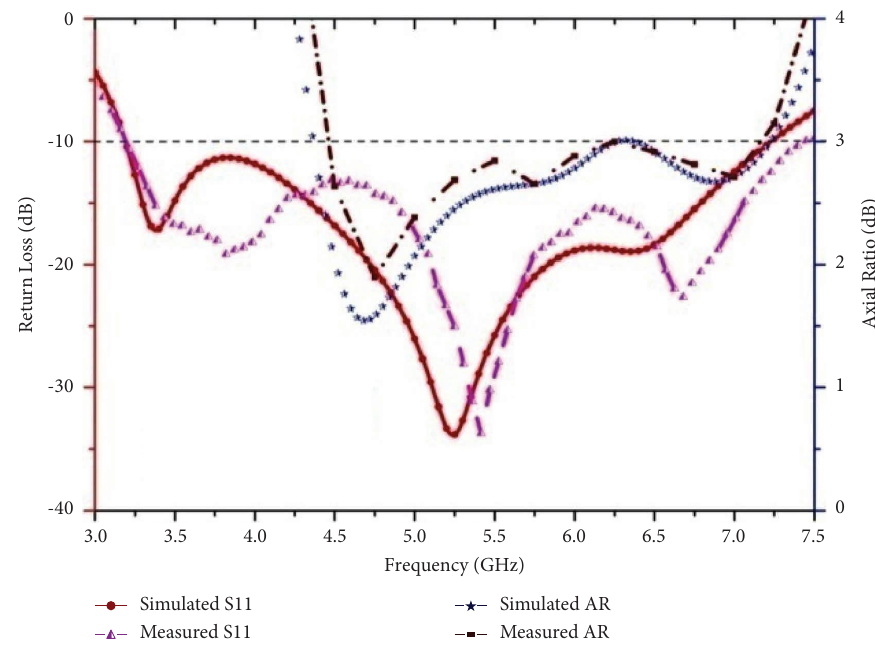
Figure 10: Simulated and measured plots of return loss and axial